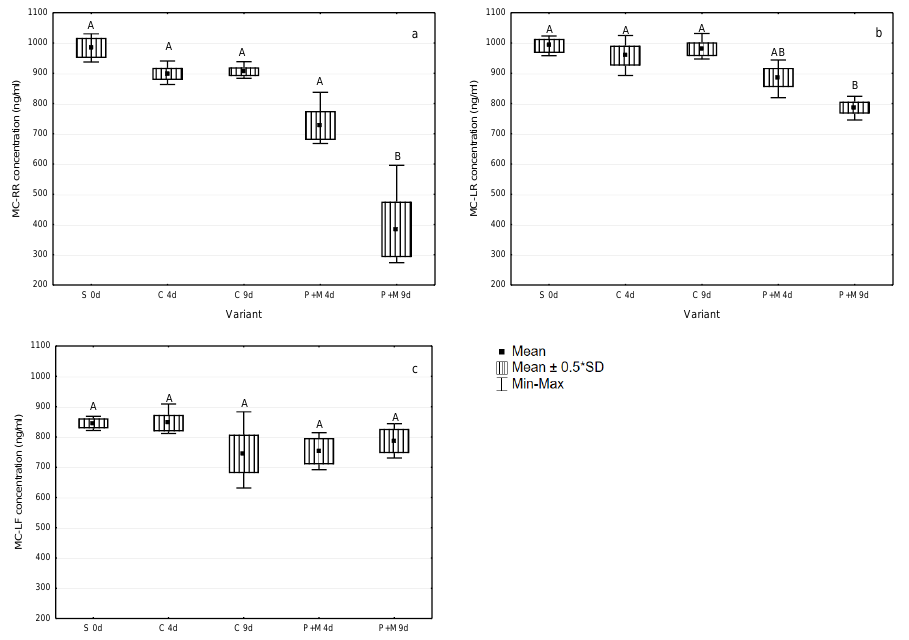
Figure 2. Concentrations of MC-RR ( a ), MC-LR ( b ), and MC-LF ( c ) in controls (C) and experimental variants with S. polyrhiza and associated microorganisms (P + M) after four and nine days of incu- bation (mean ± SD; n = 3). Uppercase letters (A, B) indicate statistically significant differences be- tween experimental vari ants (ANOVA, Tukey’s test, p < 0.05). S — experimental starting point; C — controls containing MCs, but without plants; P + M — experimental variants with MCs, plants, and associated microorganisms. Degradation products of MC-RR, MC-LR, and MC-LF, marked with capital letters A- Int. J. Environ. Res. Public Health 2022 , 19 , x FOR PEER REVIEW F, were detected in water from all experimental variants containing S. polyrhiza and mi- croorganisms after both four and nine days of incubation. In the controls, only A-LF and C-LF degradation products were observed after nine days of exposure (Figure 3, Table 2). In total, six, two, and four degradation products of MC decomposition were observed by HPLC for MC-RR, MC-LR, and MC-LF, respectively (Figure 3, Table 2). These products had the UV spectrum typical for the standard spectra and their retention times ranged from 5.6 to 16.2 min for MC-RR products (A-RR, B-RR, C-RR, D-RR, E-RR, and F-RR), from 19.3 to 20.2 min for MC-LR products (A-LR and B-RR), and from 28.9 to 33.0 min for MC-LF products (A-LF, B-LF, C-LF, and D-LF) (Table 1, Figures 4 – 6).